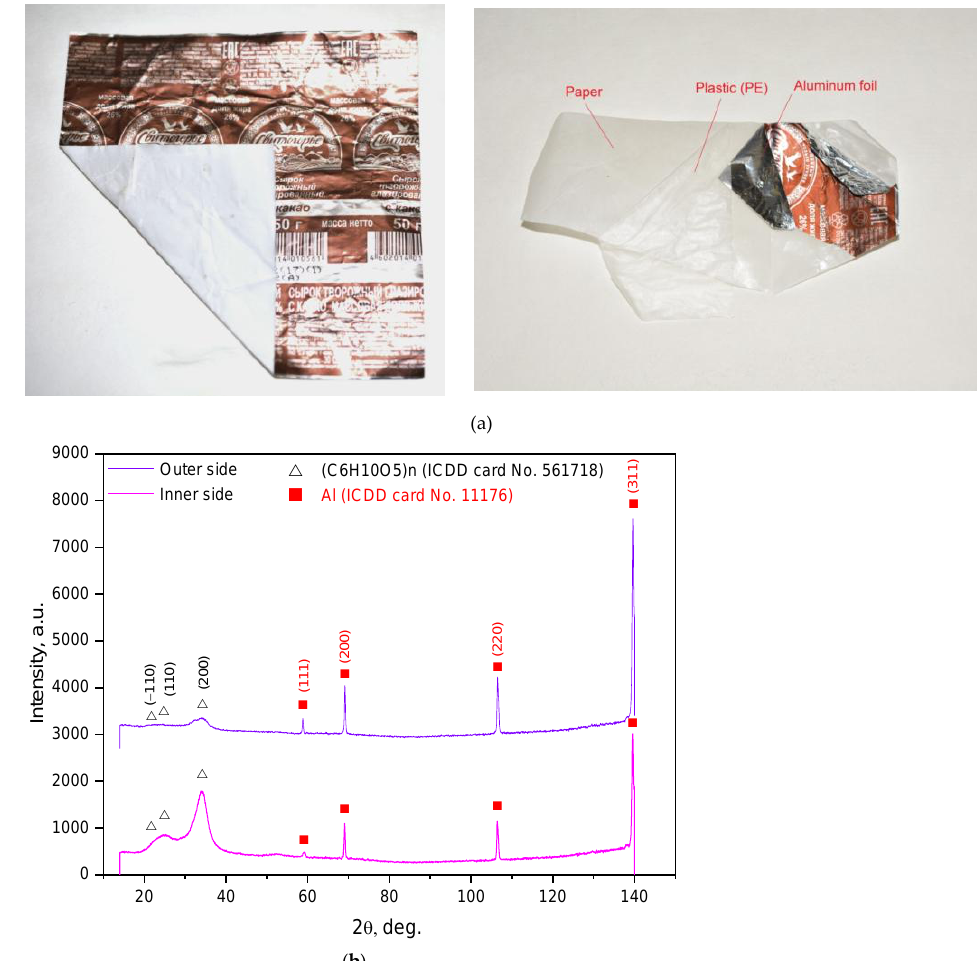
Figure 4. Characterization of paper–plastic–aluminum samples: ( a ) general view (original and with partially separated layers); ( b ) XRD patterns of the sample recorded from the inner (paper) and outer (aluminum foil) sides.